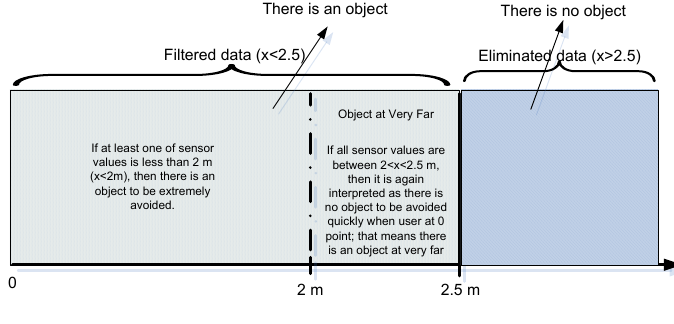
Fig. 8. Data elimination